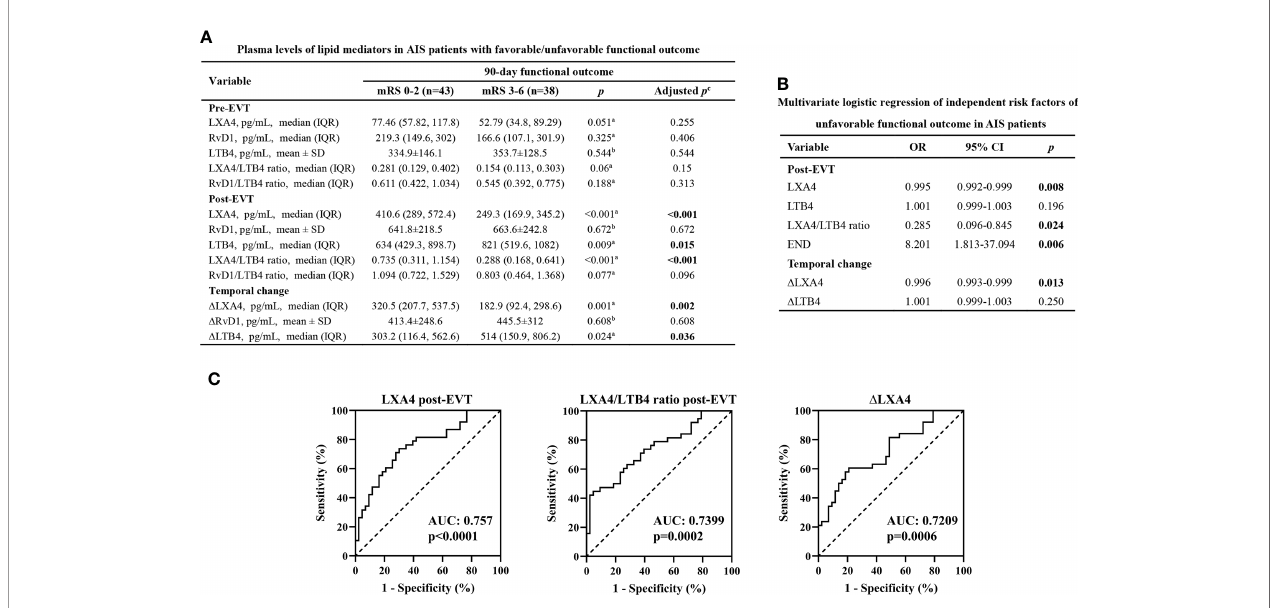
FIGURE 4 | Plasma levels of lipid mediator parameters and 90-day functional outcome. (A) Plasma levels of lipid mediator parameters in EVT-treated AIS patients with favorable or unfavorable 90-day outcomes. a Data were presented as median and IQR, and were analyzed by Mann-Whitney U test. b Data were presented as mean ± SD, and were analyzed by independent-samples t-test. c False Discovery Rate (FDR)-correction was conducted to control the error rate under multiple testing. (B) Multivariate logistic regression of independent risk factors of unfavorable 90-day outcome. Confounding factors: age, frequency rate of female, diabetes and END, and admission NIHSS scores. (C) Receiver operator characteristic (ROC) curve analyses for lipid mediator parameters to predict unfavorable 90-day outcome after successful EVT in patients with AIS. OR, odds ratio; CI, con fi dence interval. END, early neurological deterioration. AUC, area under the